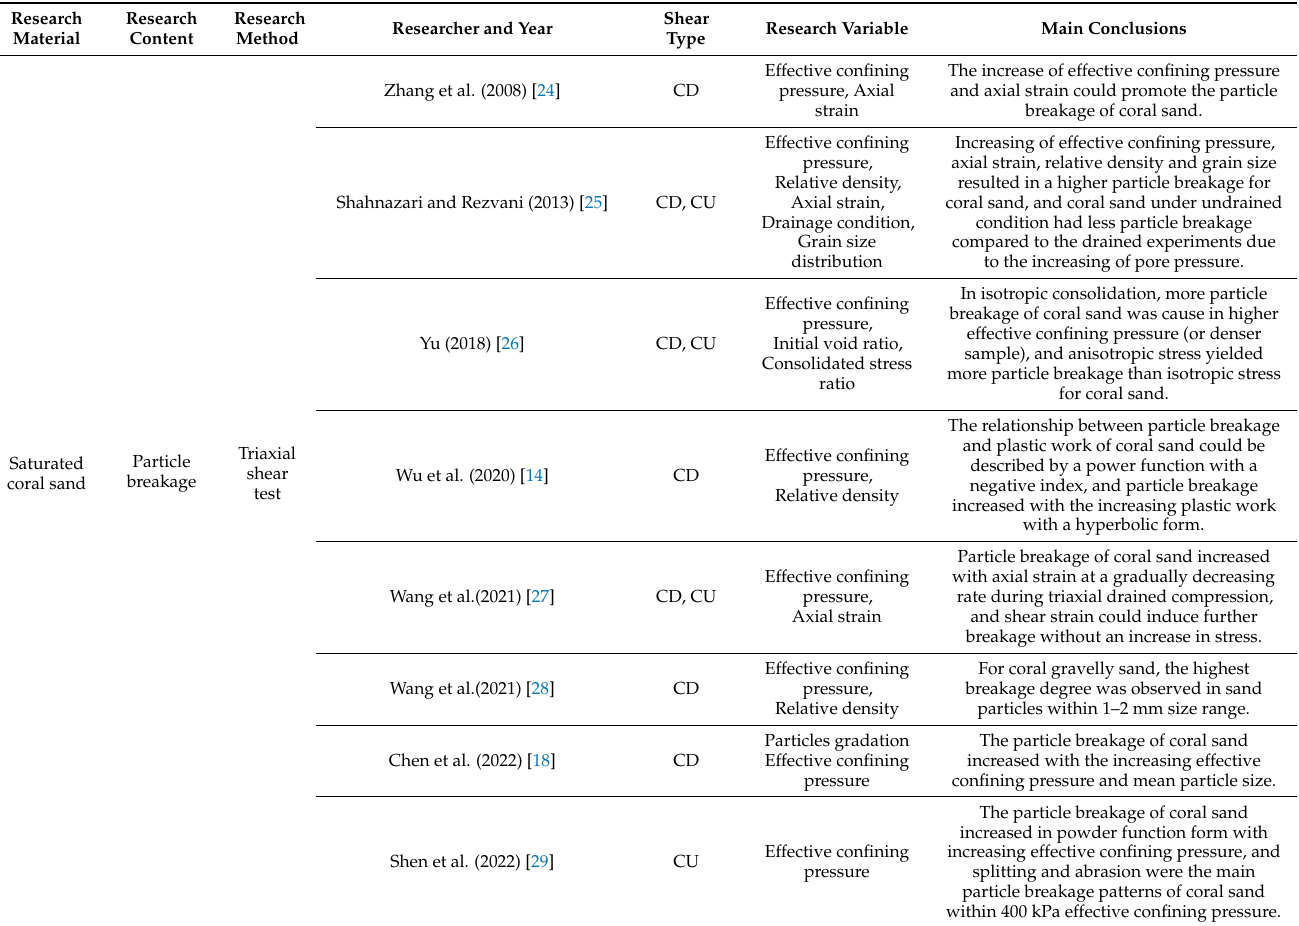
Table 2. Pervious research on particle breakage of coral sand based on triaxial shear